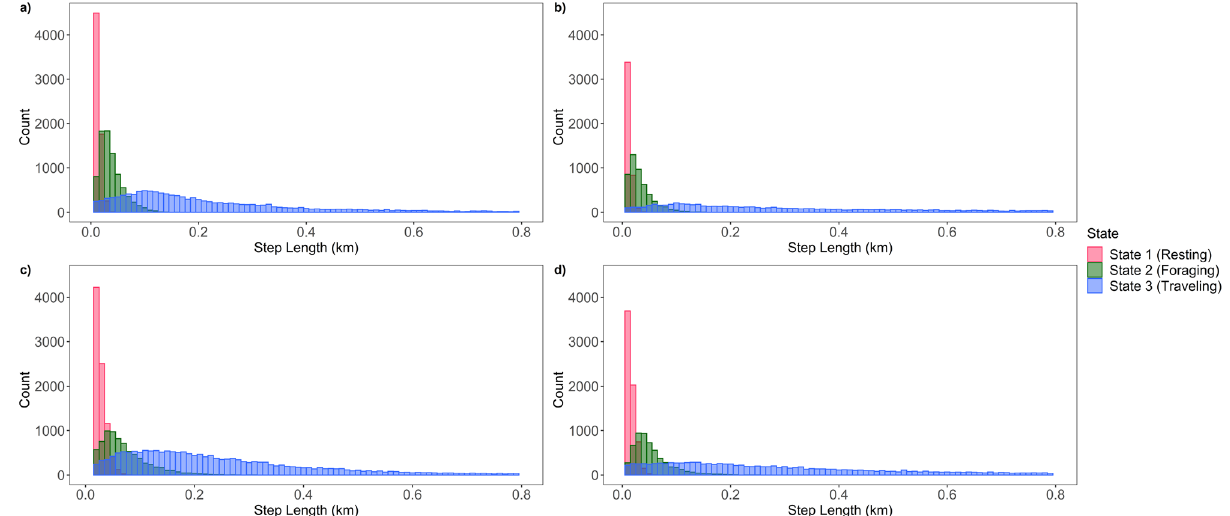
Figure 2. Step-length parameter distributions from three-state hidden Markov models (HMMs) for wild pigs ( Sus scrofa ) in the Southeast USA by sex and season: ( a ) females in low-forage months (January–April); ( b ) males in low-forage months; ( c ) females in high-forage months (May–December); ( d ) males in high-forage ing the ubiquitous establishment of wild pigs across the Savannah River Site 33 . Females also selected locations closer to streams and avoided areas near roads. In contrast, males in the low-forage season selected home ranges in or near upland pines, shrub/herbaceous vegetation, and bottomland hardwoods (Fig. 5). In addition, males selected areas close to streams and primary roads. During the high-forage season, males selected resources simi- larly to the low-forage season, with the main difference of primary roads no longer being an important driver of home range placement (Fig. 5). AUC values in the low-forage season models for females and males were 0.62, 0.66 and in the high-forage season as 0.64, 0.59, respectively. Third order. During the resting state, female wild pigs in the low-forage season strongly selected areas in or close to bottomland hardwoods and shrub/herbaceous habitats (Fig. 6, Supplementary Table S5). For example, there was a 23% decrease in use for every 100 m farther away from bottomland hardwoods, and a there was a 10% decrease in use for every 100 m farther away from shrub and herbaceous habitats. During the high-forage season, female wild pigs selected resting areas similarly to the low-forage season with the addition of a strong selection for upland hardwoods (Supplementary Table S5). Also, the resting model for females in both seasons indicated they avoided areas near secondary roads and streams (Fig. 6). Similarly, males selected resting areas in or close to bottomland hardwoods, upland hardwoods, and shrub/herbaceous communities in both seasons. However, males differed between seasons in selecting to rest near streams during the low-forage season but not during the high-forage season. For example, males demonstrated a 5.4% decrease in use for every 100 m farther away from a stream during the low-forage season (Fig. 6). Throughout the foraging state, females differed in relative probability of selection for specific vegetation types and landscape characteristics between the low- and high-forage seasons (Fig. 6). For example, females selected areas near primary roads and bottomland hardwoods during the low-forage season, yet during the high-forage season they selected areas near upland hardwoods, upland pines, bottomland hardwoods, and areas near primary